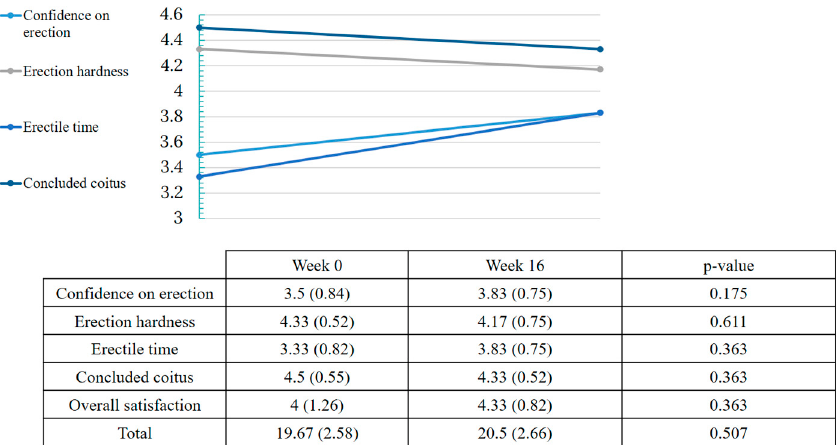
Figure 2. Effect of dupilumab on female sexual function. Values of total FSFI and subcategories in weeks 0 and 16. Two-tailed * p < 0.05 was considered statistically significant in all tests.